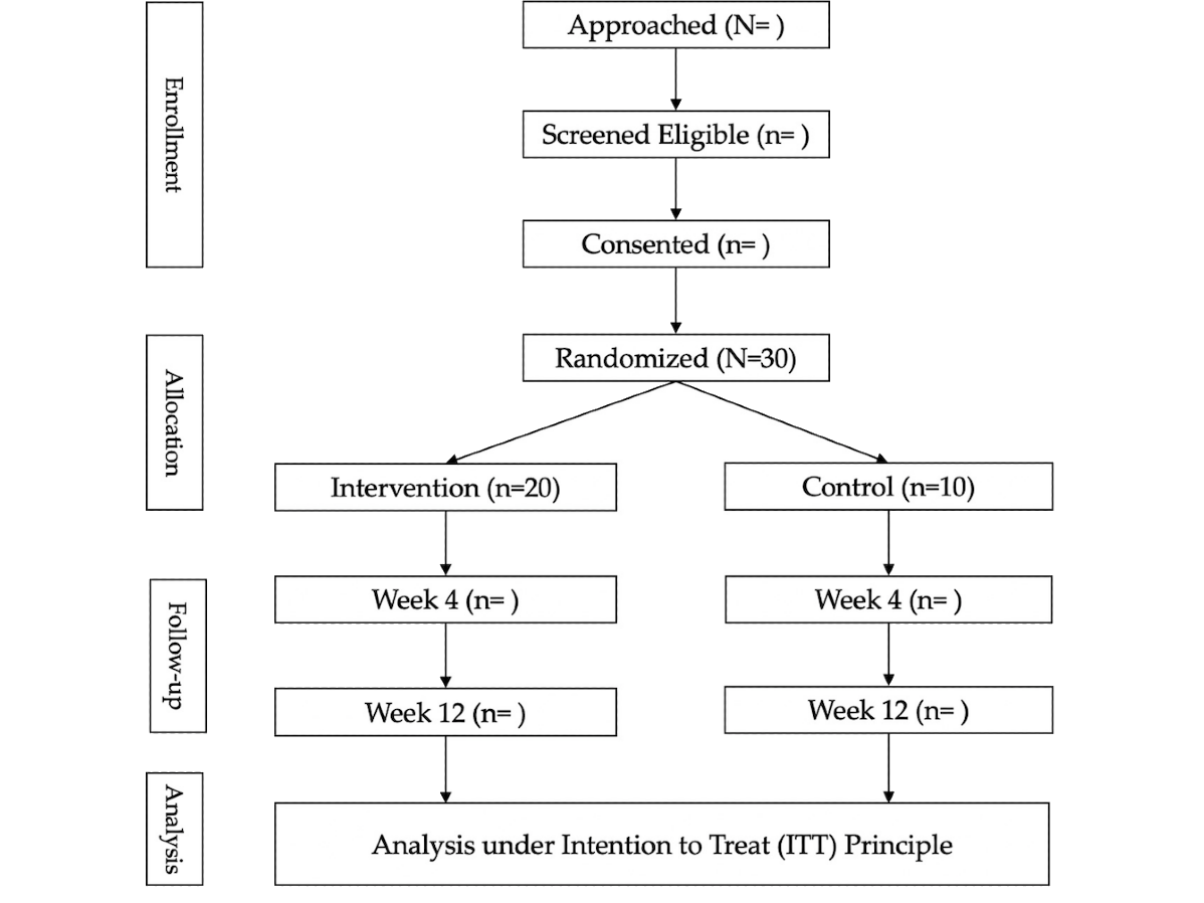
Figure 1. Phase II: CONSORT (Consolidated Standards of Reporting Trials) diagram of participant flow through the